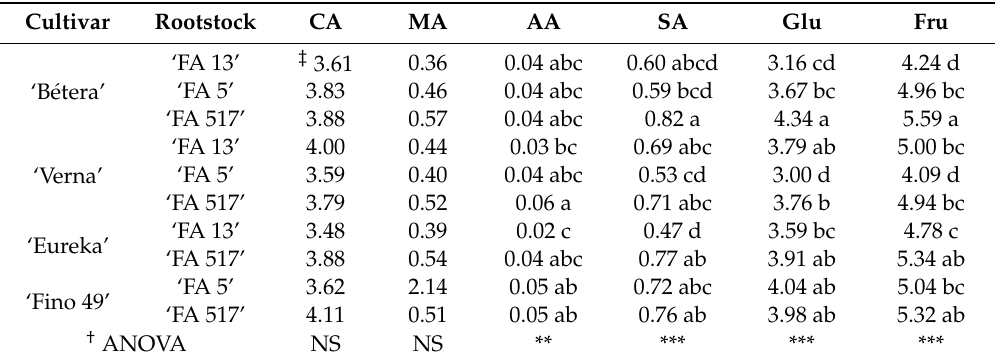
Table 4. E ff ect of di ff erent rootstocks on lemons (‘B é tera’, ‘Verna’, ‘Eureka’ and ‘Fino 49’) fruit citric